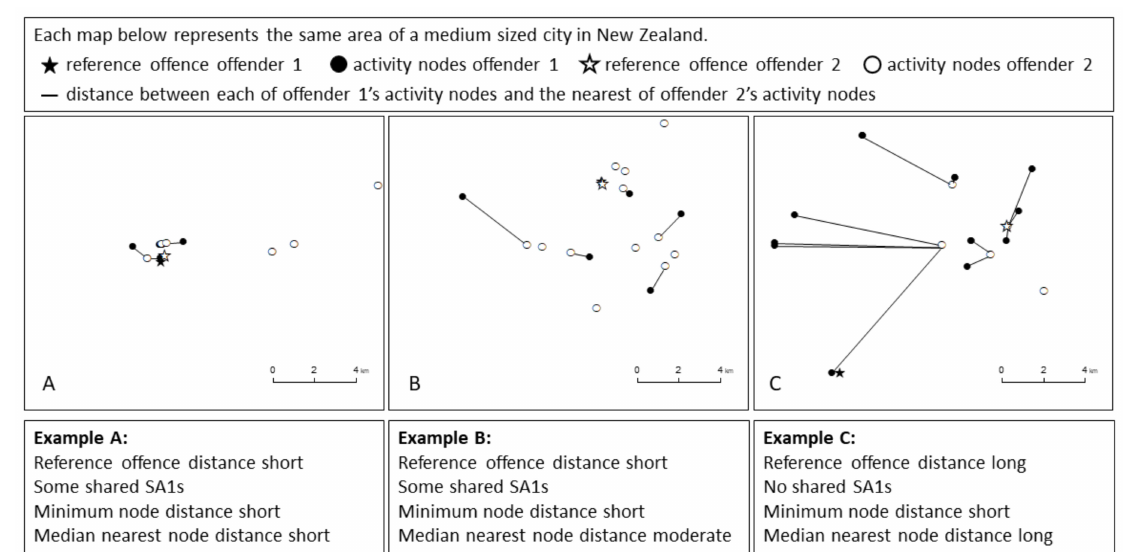
Figure 1. Illustration of activity space similarity measures for three pairs of offenders: ( A ) with close reference offenses and high activity space similarity on all three measures, ( B ) with close reference offenses and some activity space similarity, depending on measure, and ( C ) with distant reference offenses and less activity space